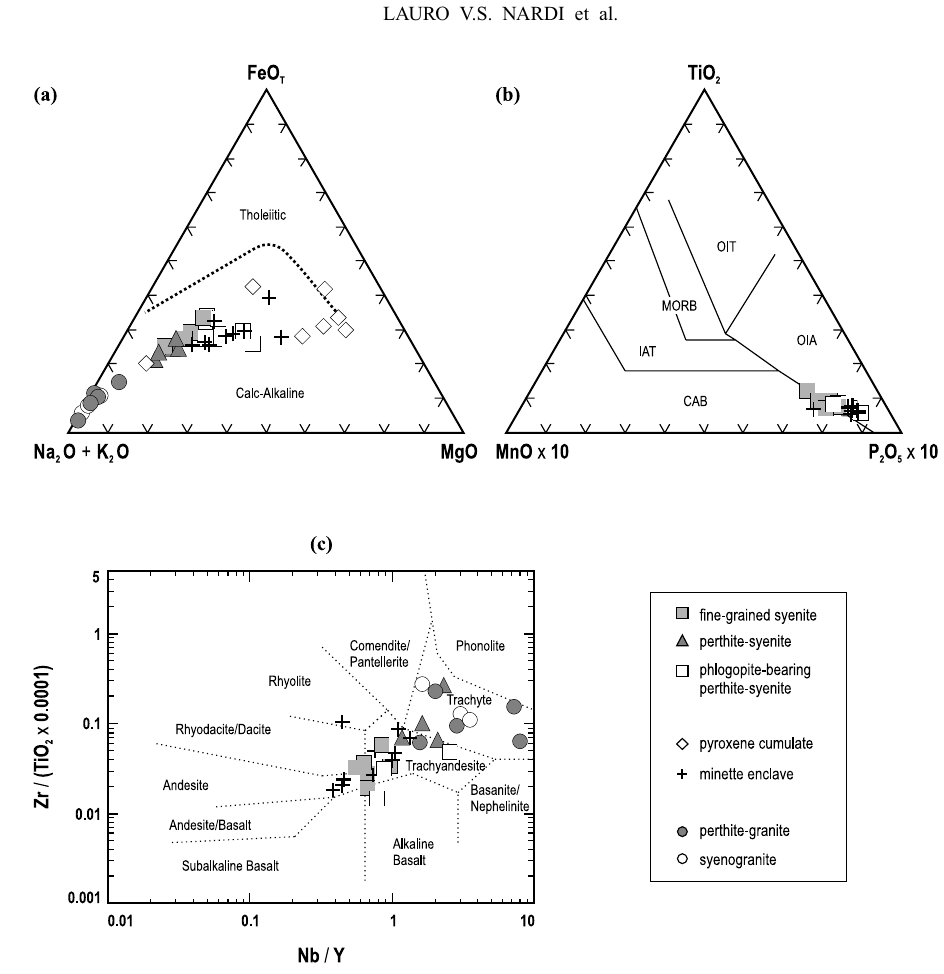
Fig. 6 – Major and trace element plots: (a) in the AFM diagram the samples plot in the non-tholeiitic field; (b) most samples plot in the fields of ocean island arcs (OIA) and continental arc basalts (CAB); OIT – ocean island tholeiites, MORB – mid-ocean ridge basalts, IAT – island arc tholeiites; (c) the samples plot mostly in the fields of alkaline rocks – trachyandesites and trachytes.